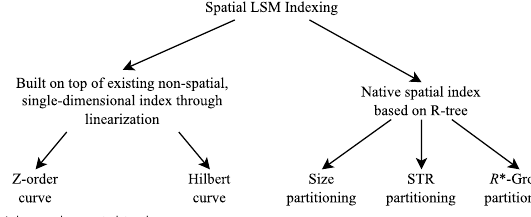
Fig. 4 Types of LSM-based spatial